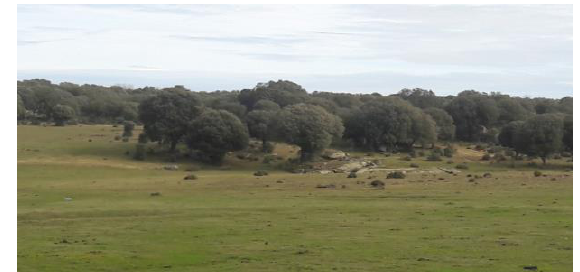
Figure 2. Typical landscape of the dehesa, combining pasture with sparse trees ( Quercus ilex